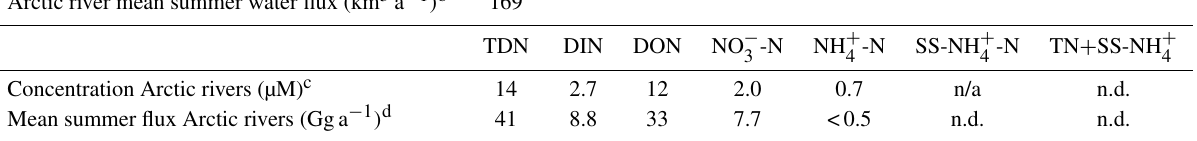
) species (total nitrogen – TN) from the 4